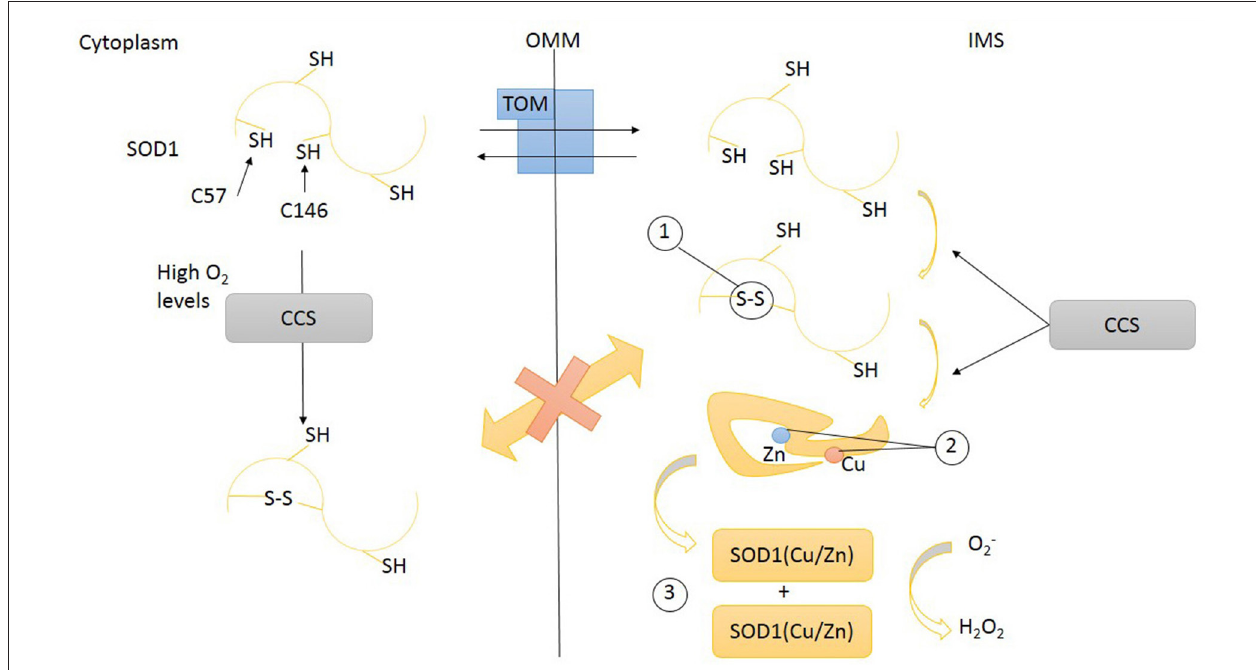
copper chaperone for superoxide dismutase (CCS). Disulfide bonds prevent SOD1 leakage from mitochondria through TOM. High O 2 levels might also induce CCS and SOD1 protein folding in cytoplasm. SOD1, superoxide dismutase 1; CCS, copper chaperone for superoxide dismutase; TOM, translocase of outer membrane; OMM, outer mitochondrial membrane; IMS, intermembrane